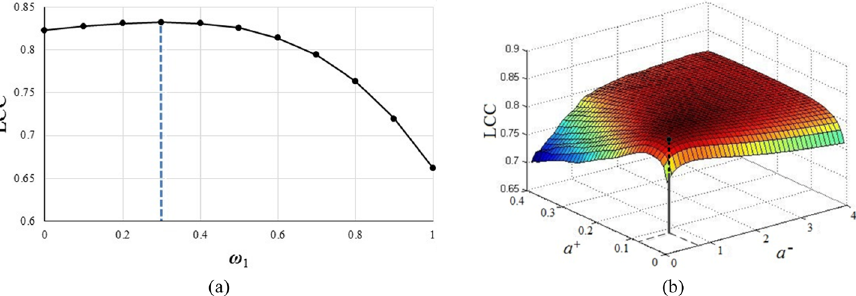
Fig 5. Parameter determinations in the proposed VQA method. (a) Tuning Performance of ω 1 . (b) Tuning Performance of a + and a -